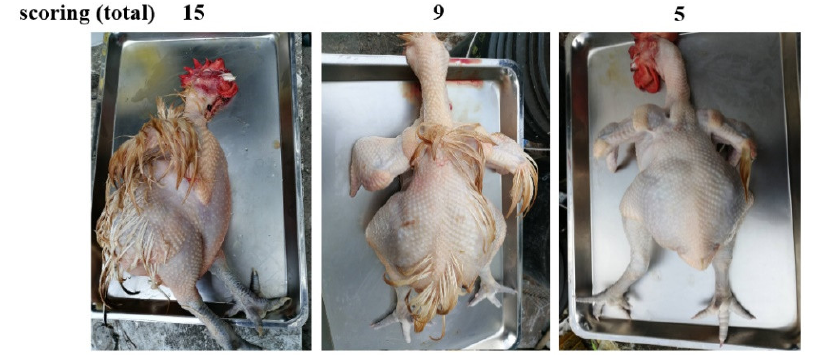
Figure 2. The typical carcass morphology of defeathering scores of young Red Feather country chickens. The scores of each part (neck, body, wings, legs, and tail) of individual bird were combined to produce a total with a range from a minimal score 5 to 15 for maximum. A typical carcass morphology with total scores of 15, 9, or 5 is shown.